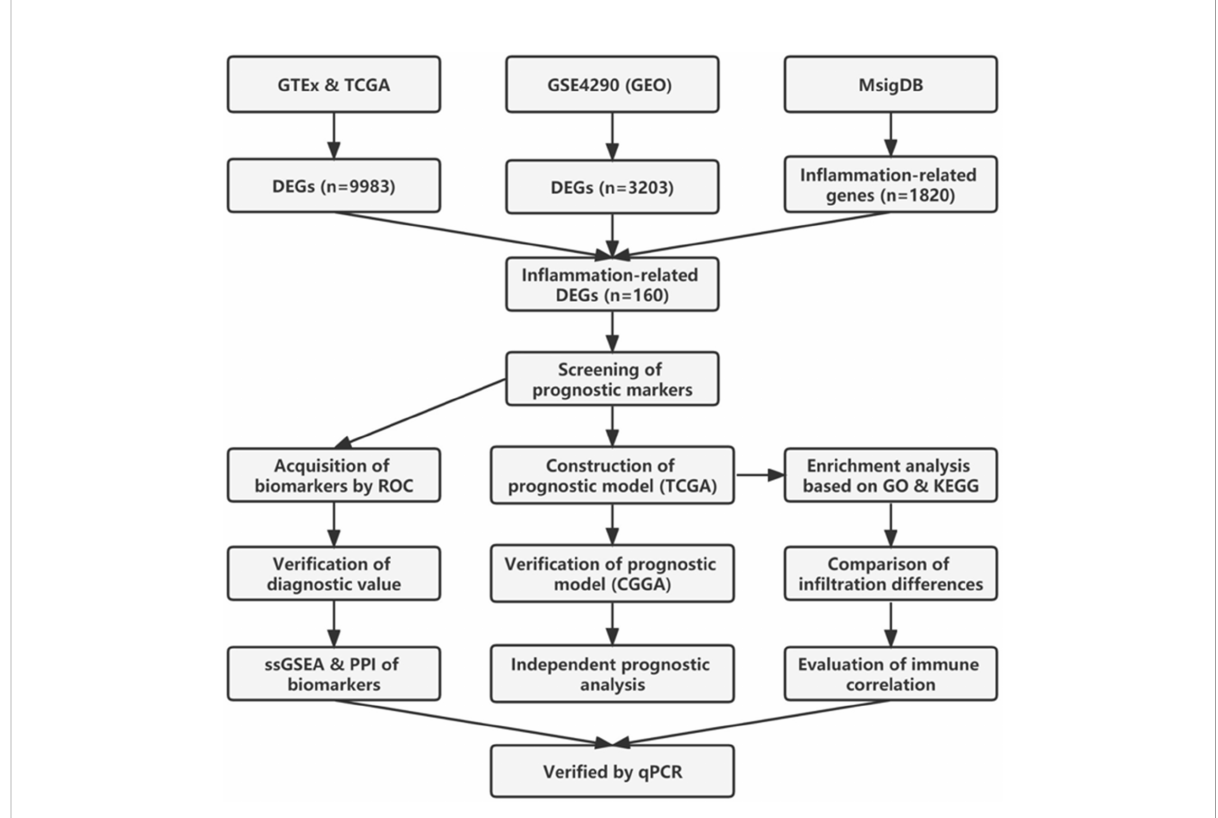
FIGURE 1 Flowchart of the present